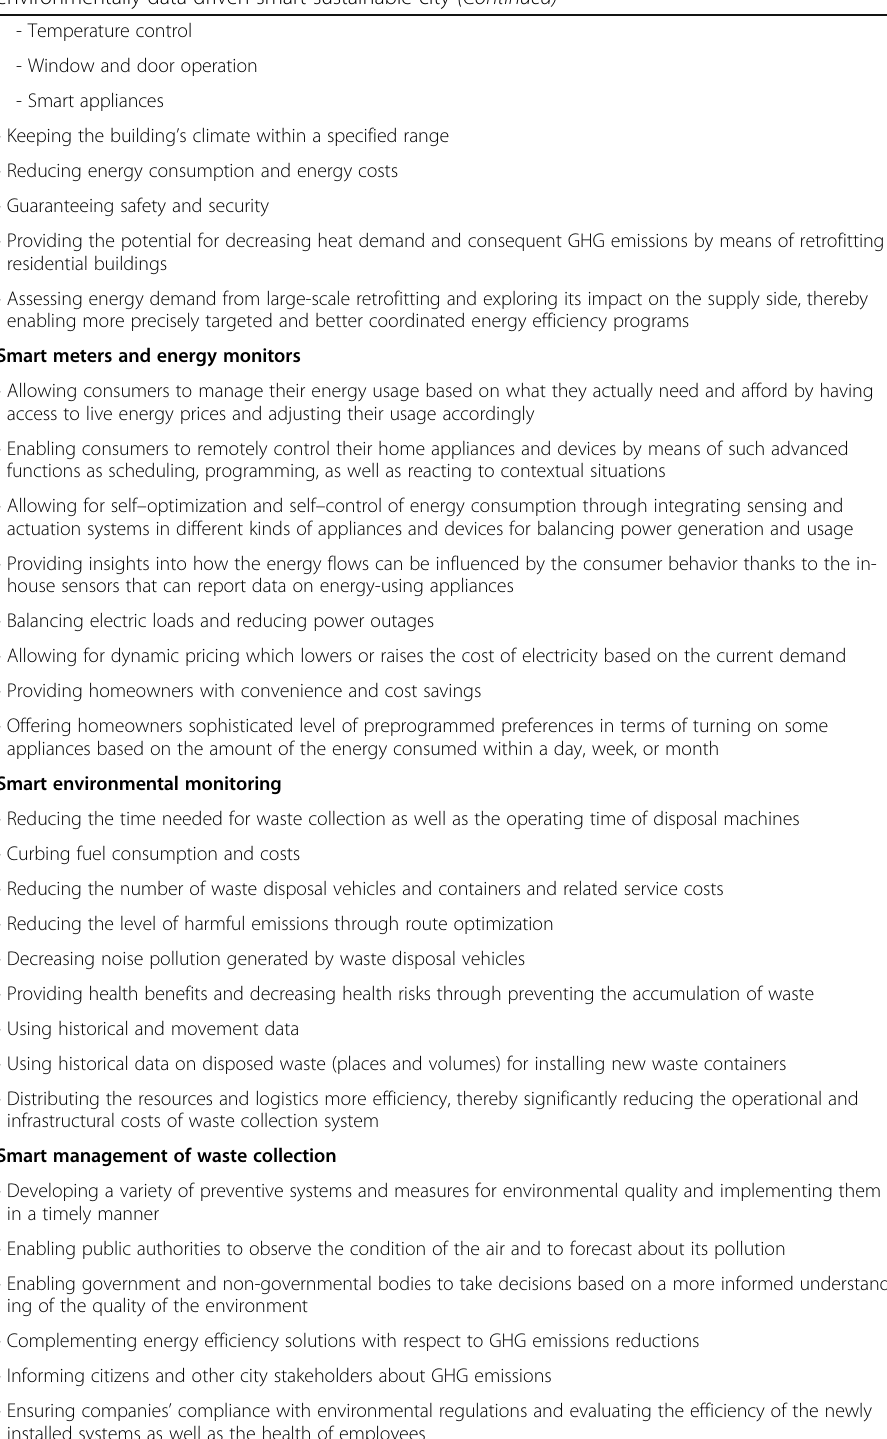
Table 6 The key benefits, potentials, and opportunities of the data-driven smart city and the environmentally data-driven smart sustainable city